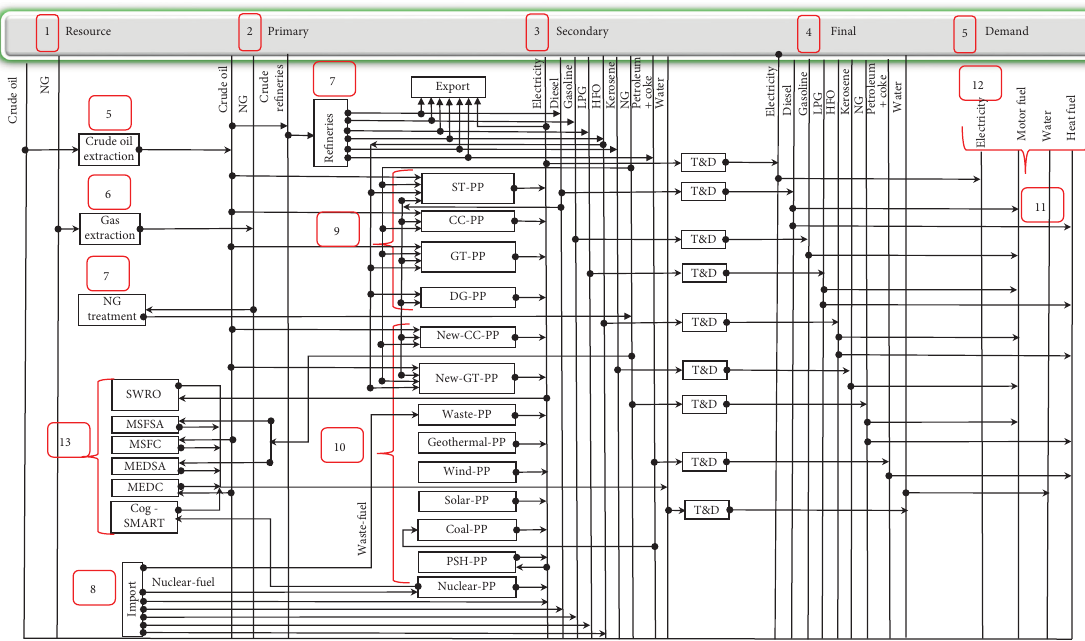
Figure 1: Simplified Saudi Arabian energy system flow diagram including the energy chains, levels, and technologies structured in this